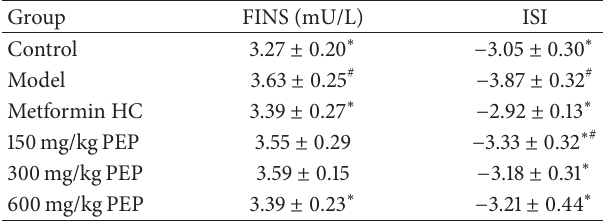
Table 3: The effect of PEP on FINS levels and the ISI in DM rats. Group FINS (mU/L) ISI Control 3.27 ± 0.20 ∗ − 3.05 ± 0.30 ∗ Model 3.63 ± 0.25 # − 3.87 ± 0.32 # Metformin HC 3.39 ± 0.27